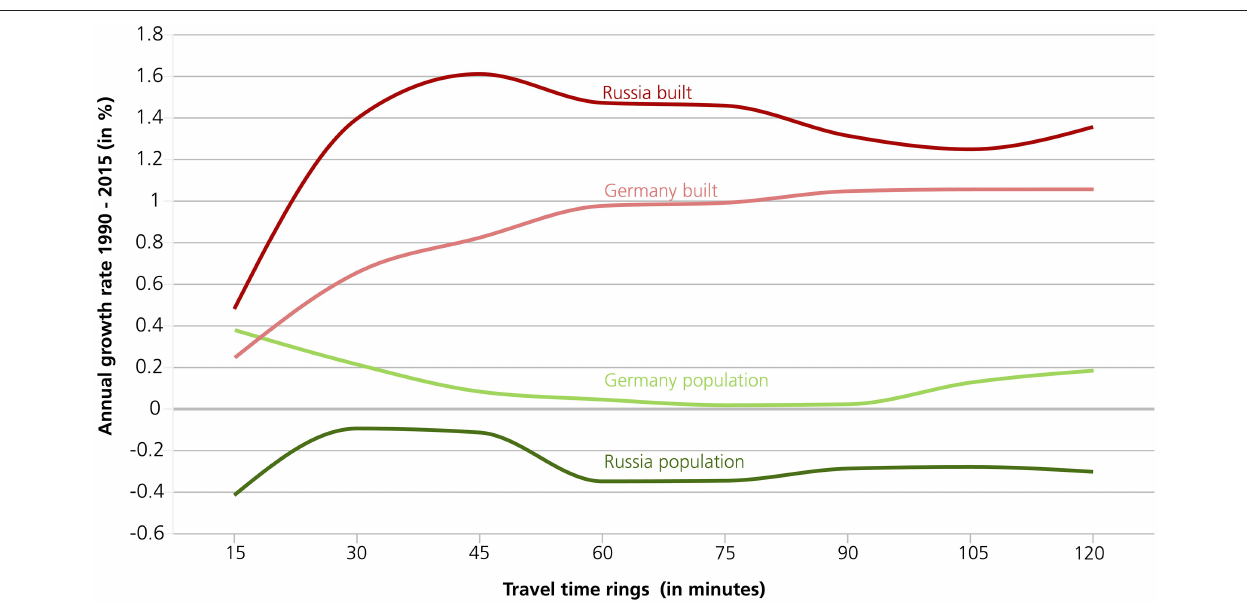
FIGURE 3 | Average built-up and population growth rates for German and Russian city regions between 1990 and 2015 (Graphic: C.